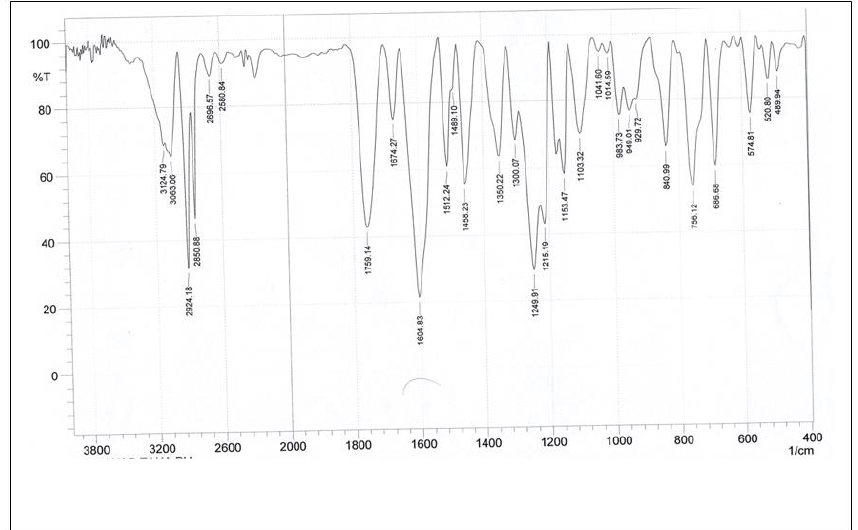
Fig. 8. FT-IR spectrum of PH polyester